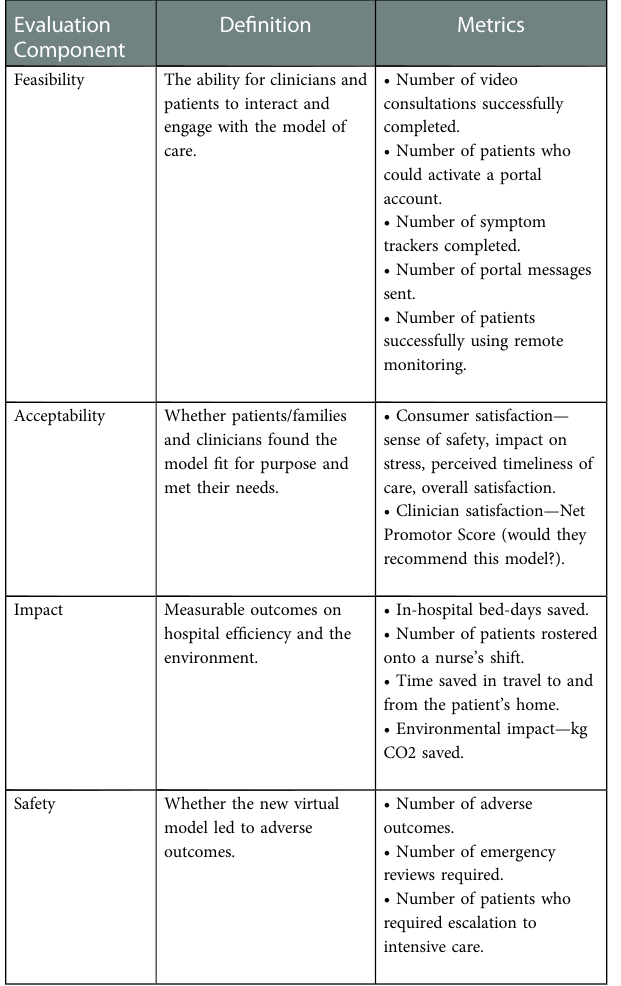
TABLE 1 RCH virtual care evaluation framework. Evaluation Component